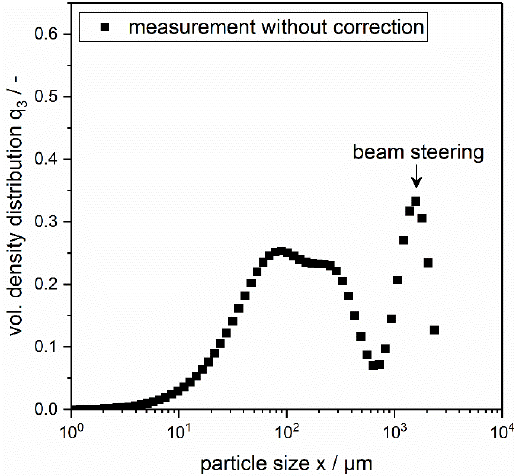
Figure 4. Exemplary volumetric density distribution with beam-steering effect (µ = 0.69 Pa·s; p G = 0.8 MPa; 𝑉̇ 𝐿 = 20 L/h; GLR = 0.35). The real and apparent distribution parts overlap. No beam-steering correction performed.